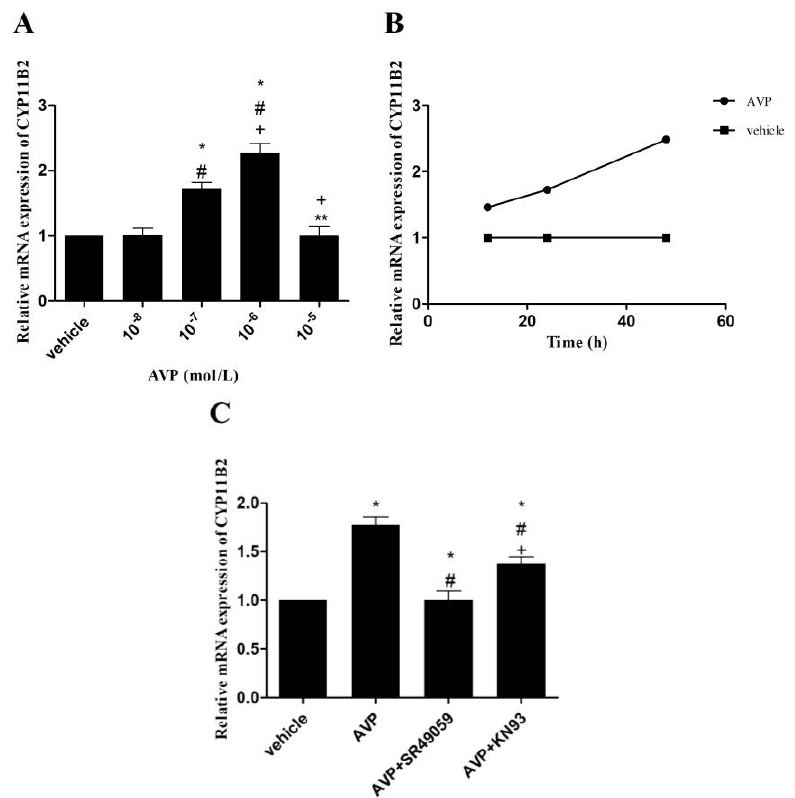
Figure 4. Effects of AVP on CYP11B2 mRNA expression in CMECs. ( A ) Effects of different concen- trations of AVP on CYP11B2 mRNA expression. * p < 0.05 vs. vehicle; # p < 0.05 vs. 10 −8 mol/L AVP; + p < 0.05 vs. 10 −7 mol/L AVP; ** p < 0.05 vs. 10 −6 mol/L AVP. ( B ) AVP (10 − 7 mol/L) time-independently upregulated CYP11B2 mRNA expression. ( C ) Effects of different antagonists on AVP-upregulated CYP11B2 mRNA expression. AVP, 10 −7 mol/L; SR49059, 10 −6 mol /L; KN93, 10 −6 mol /L. * p < 0.05 vs. vehicle; # p < 0.05 vs. AVP; + p < 0.05 vs. (AVP + SR49059).